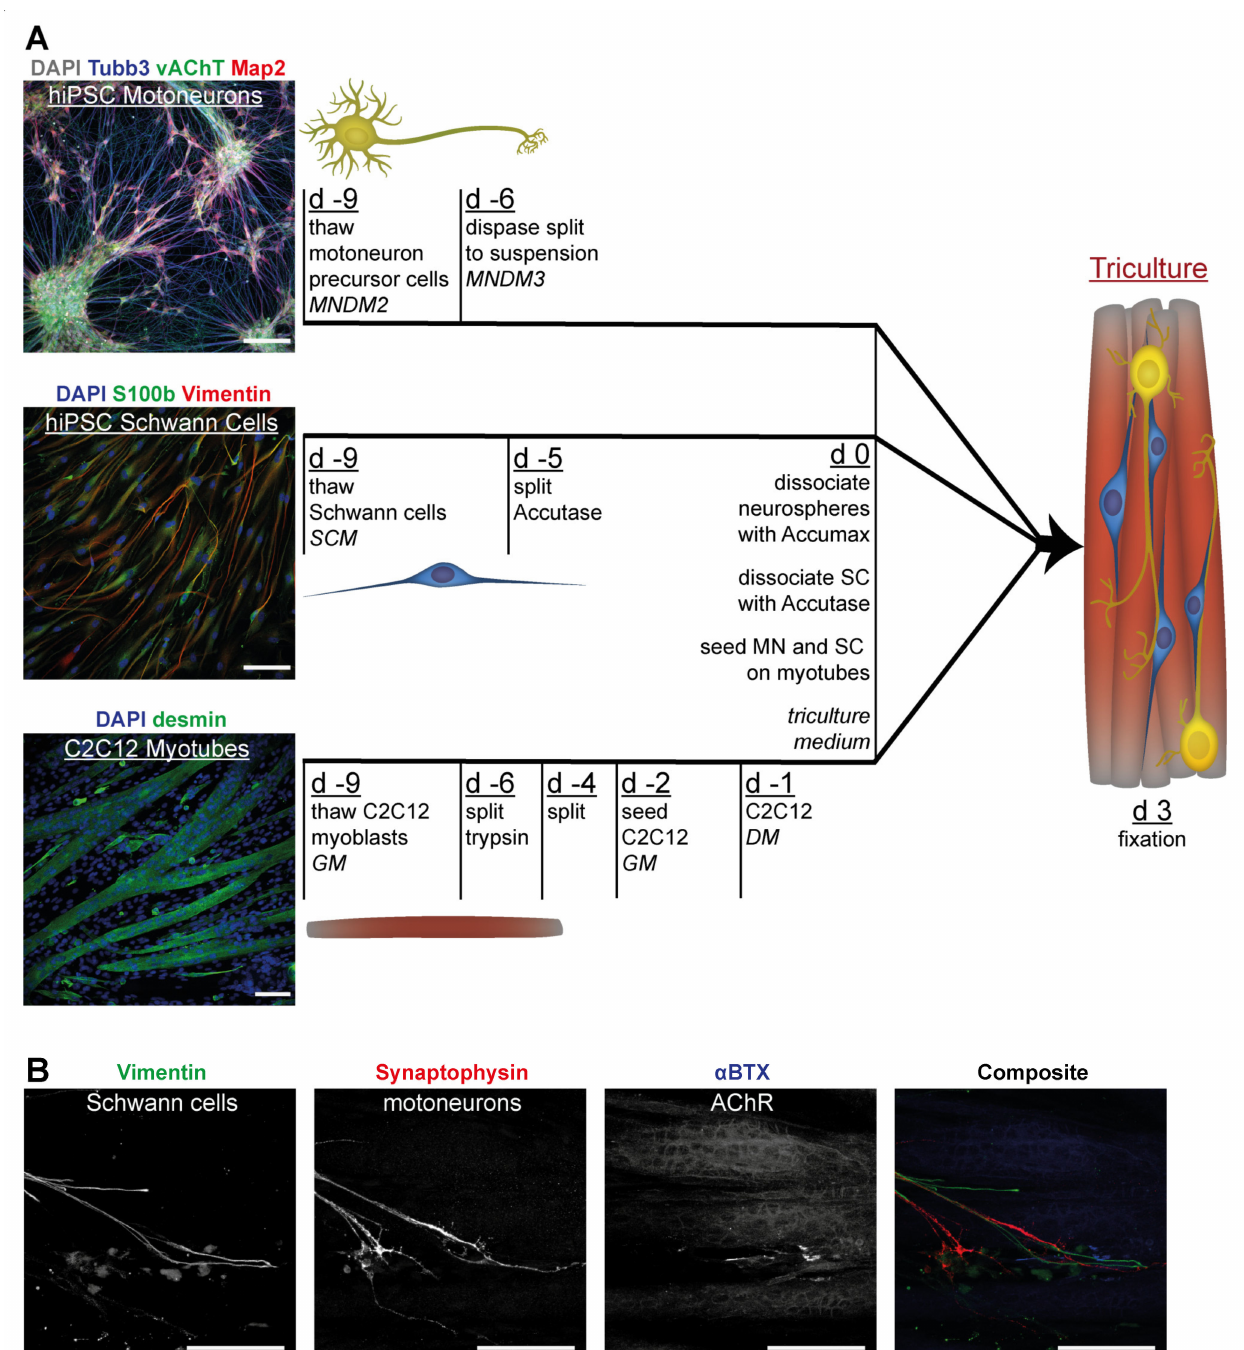
Figure 5. Tricultures can be set up from cell stocks within nine days. ( A ) Schematic timeline to set up tricultures, work steps, and different culture media shown. MNDM: MN differentiation medium; SCM: SC medium; GM: myoblast growth medium; DM: myotube differentiation medium. All medium compositions detailed in Methods section. Micrograph inserts depict fluorescence signals of representative individual cultures, respective stainings indicated on top of each panel. Scale bars: 100 µ m. ( B ) Representative confocal image depicting SC (green in composite, Vimentin), MN (red in composite, Synaptophysin), and AChR clusters on C2C12 myotubes (blue in composite, α BTX staining). Scale bars: 50 µ